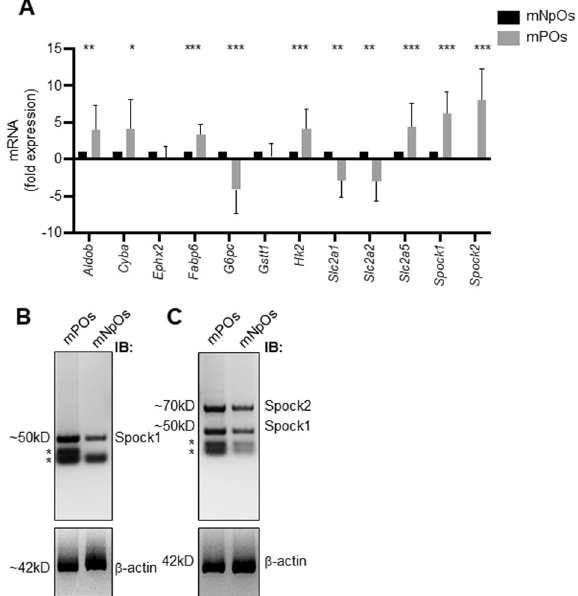
Fig. 2 The murine duodenal Apc Min Fbxw 7 Δ G -POs culture condi- tions compare to the duodenal Apc Min Fbxw 7 Δ G -NPOs, impact intestinal organoid cell expression selected metabolic genes. A qRT-PCR analysis of mRNA encoding the indicated genes respon- sible for intestinal metabolism of duodenal Apc Min Fbxw7 Δ G -POs and Apc Min Fbxw7 Δ G -NPOs organoid cells after the 48 h incubation period. Experiments were performed in triplicate for each organoid type from three separate litters samples as outlined in Fig. 1. Results were normalised to β -actin in the same sample, and an average expression data from mPOs samples are presented as fold- induction/repression over mNPOs. Mean ± SE ( n = 3; * P < 0.05; ** P < 0.01; *** P < 0.001). B, C Western blot analysis of mPOs and mNPOs organoids proteins using antibodies against Spock1, Spock2, and the loading control β -actin. Experiments were performed on at least two independent